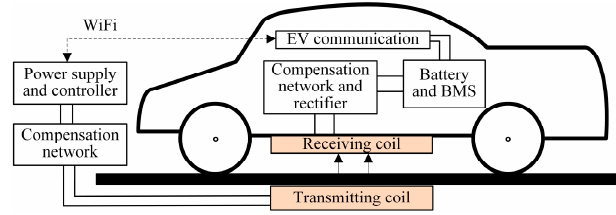
Figure 1. Schematic diagram of EV wireless charging system.